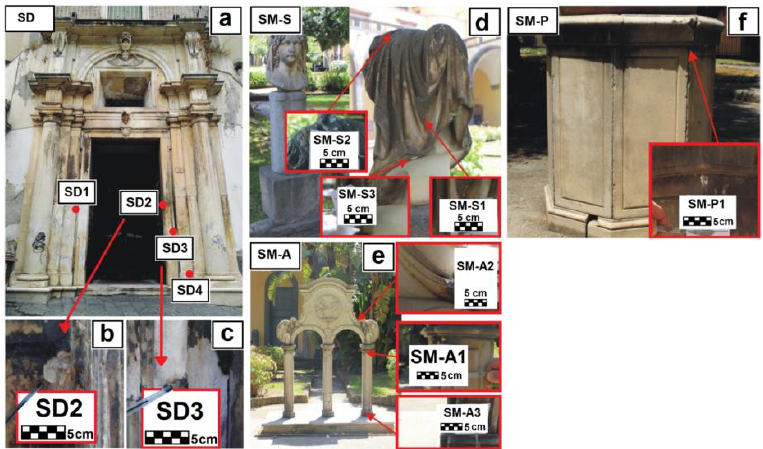
Figure 2. Sampling points of fragments collected at: San Domenico Maggiore (SD series) ( a – c ); Marble bust of the San Marcellino e Festo Cloister (SM-S series) ( d ); Arch sculpture of the San Marcellino e Festo Cloister (SM-A series) ( e ); Water well of San Marcellino e Festo Cloister (SM-P series) ( f ). Samples with location description and heights are reported in Table 1. Table 1. List of the examined samples with a brief description. The sampling heights refer to the planking level. The exposition of the surfaces to washout is defined as well exposed (WELL), partially exposed (PART), or not exposed